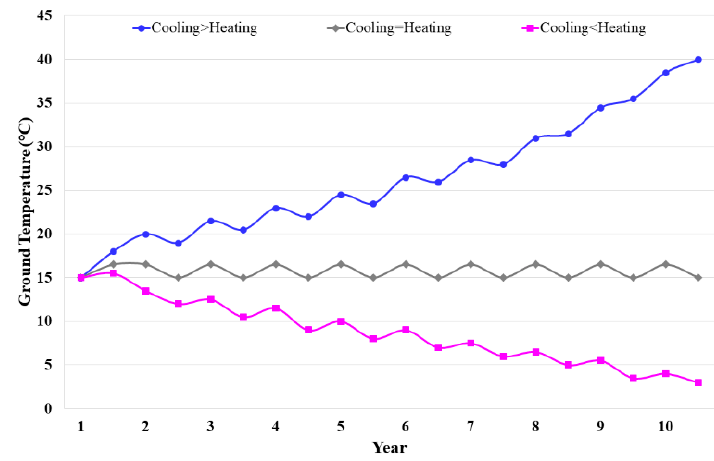
Figure 1. Ground temperature according to load.